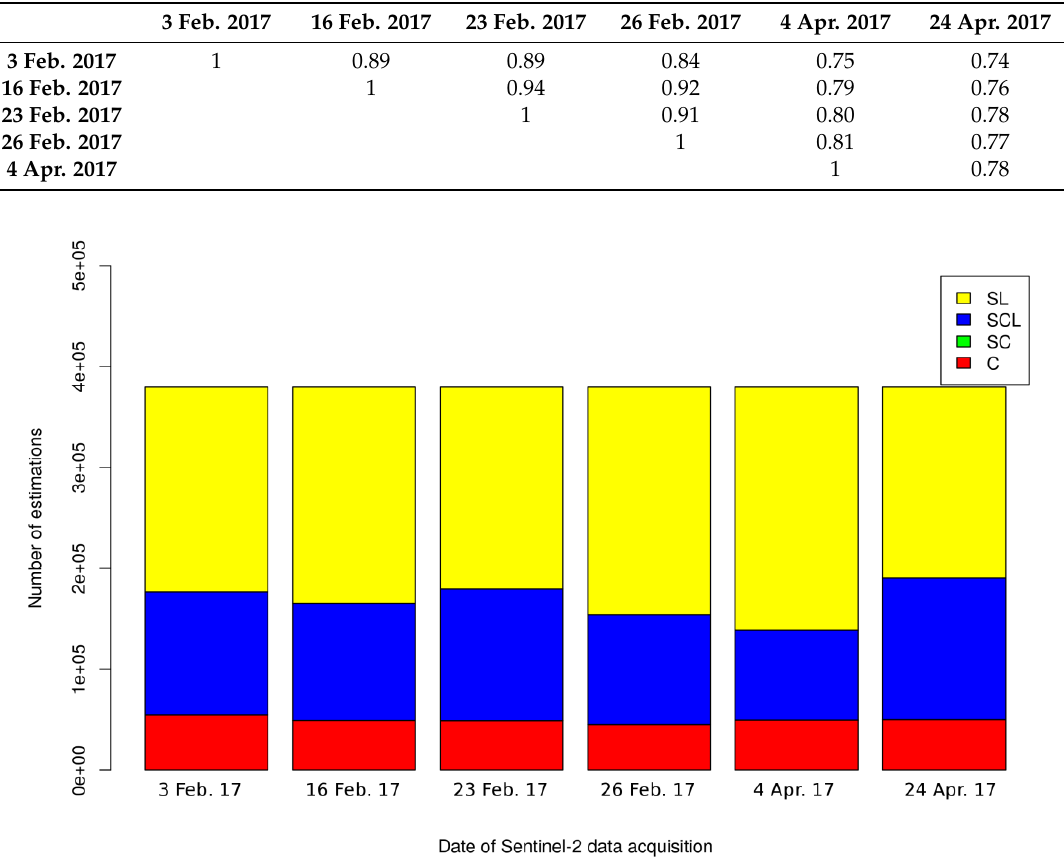
Figure 6. Distribution of the most frequent textural class estimated over bare soils pixels at each acquisition